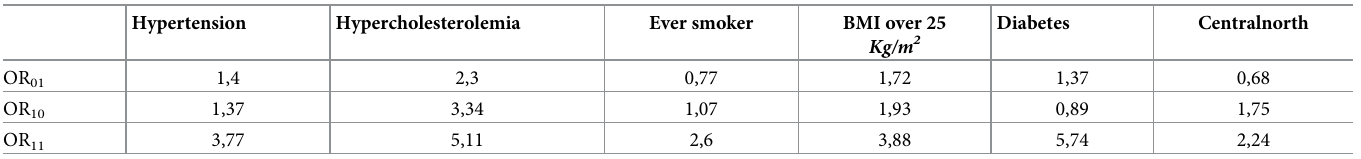
Table 4. OR calculation for obtaining the index of synergism.